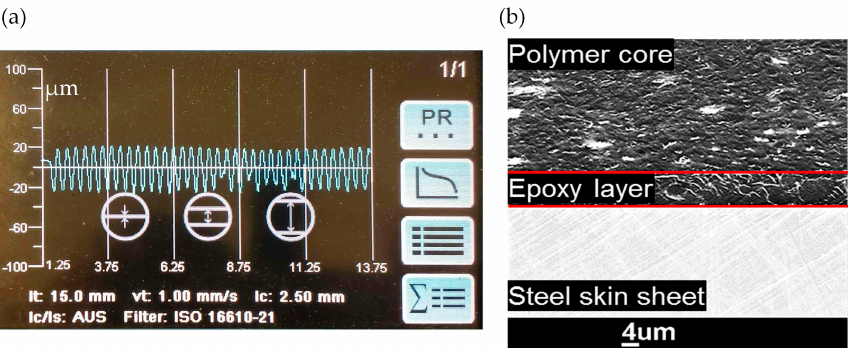
Figure 4. ( a ) Depth profile of the steel scraper (roller) used to distribute the adhesive agent, and ( b ) cross-sectional micrograph showing the thickness of the adhesive agent.